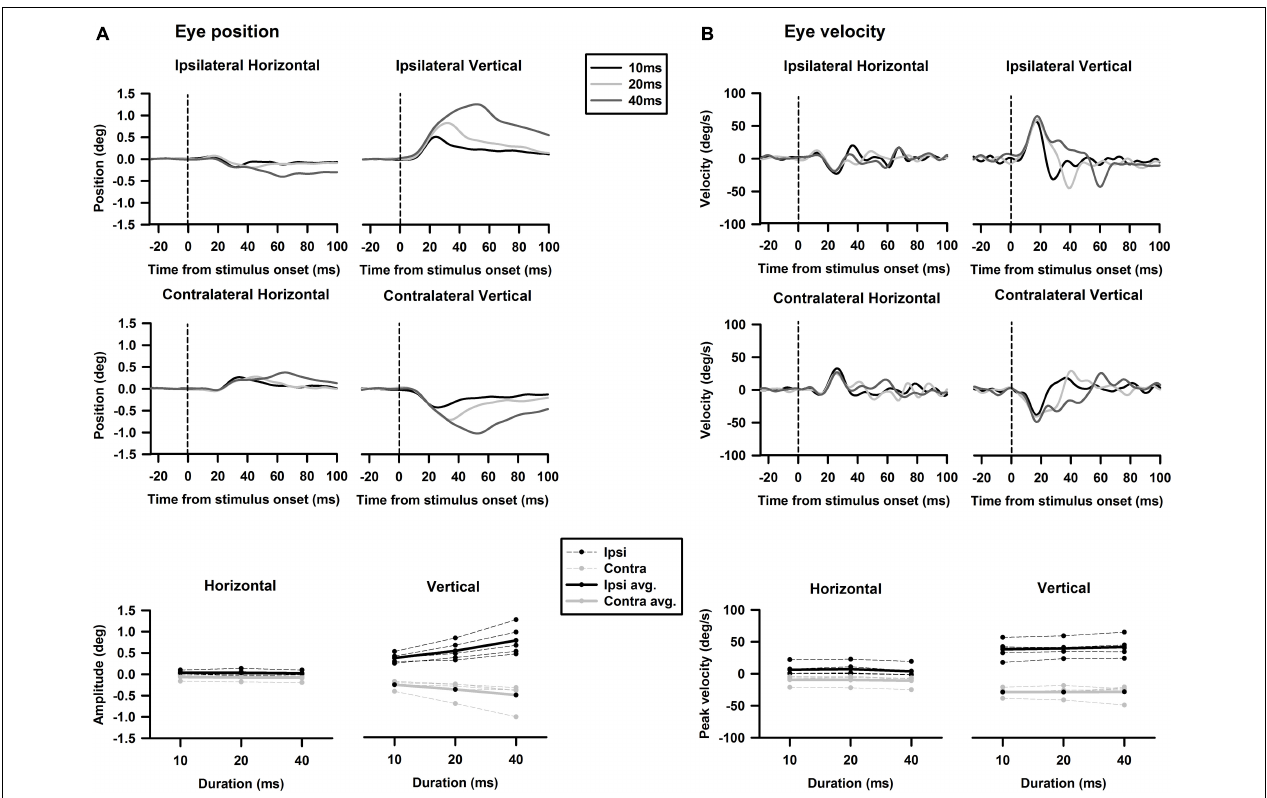
FIGURE 13 | Effects of duration on tone-bursts-evoked horizontal and vertical eye movements. (A) Tone-evoked changes in eye position. (B) Tone-evoked changes in eye